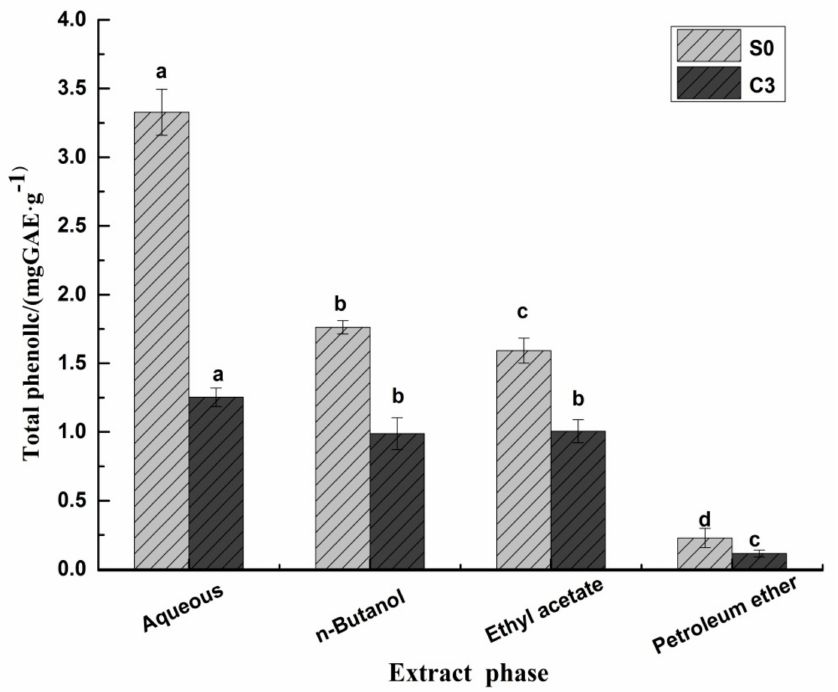
Figure 3. Total phenolic content after fractional extraction of pepper of S0 and C3. Different letters (a, b, c, and so on) on the columns indicate significant differences between the four extracts ( p < 0.05). Data are means ± standard error of